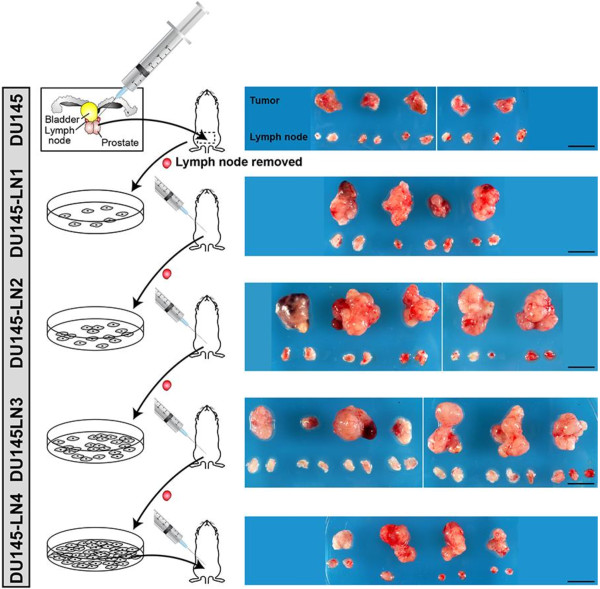
Development of a model of metastatic prostate cancer through repeated selection of spontaneous lymph node metastases from orthotopic DU145 human prostate tumors. Schematic (left panels) of the experimental approach shows orthotopic prostate inoculation of DU145 cells. Lymph nodes were removed and cultured, and selected tumor cells subject to repeated rounds of orthotopic injection. Right panels show gross anatomy of tumors and lymph nodes 5 weeks after all DU145 sublines were reinjected (this figure is modified with permission from [21]). Scale bar = 1 cm.